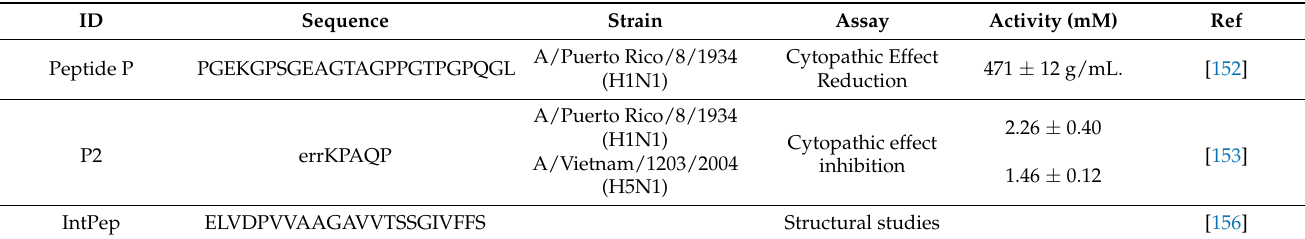
Table 4. Most representative peptides targeting